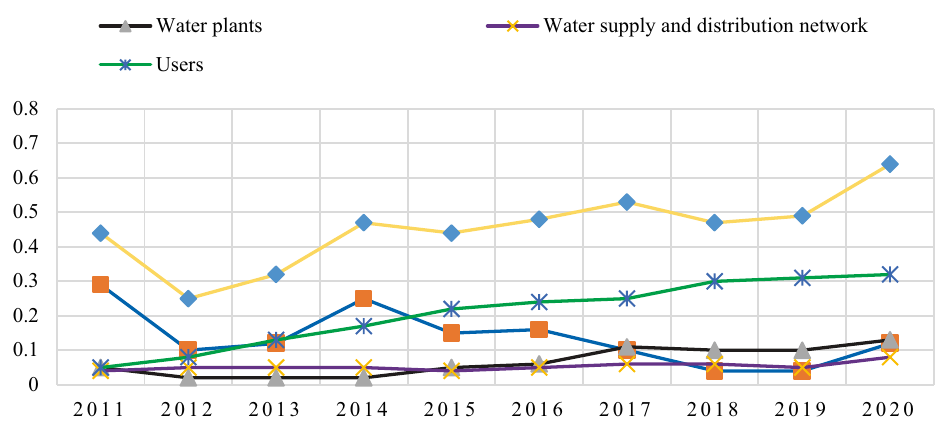
Figure 10. Comprehensive evaluation index trend of toughness capability by entropy weight